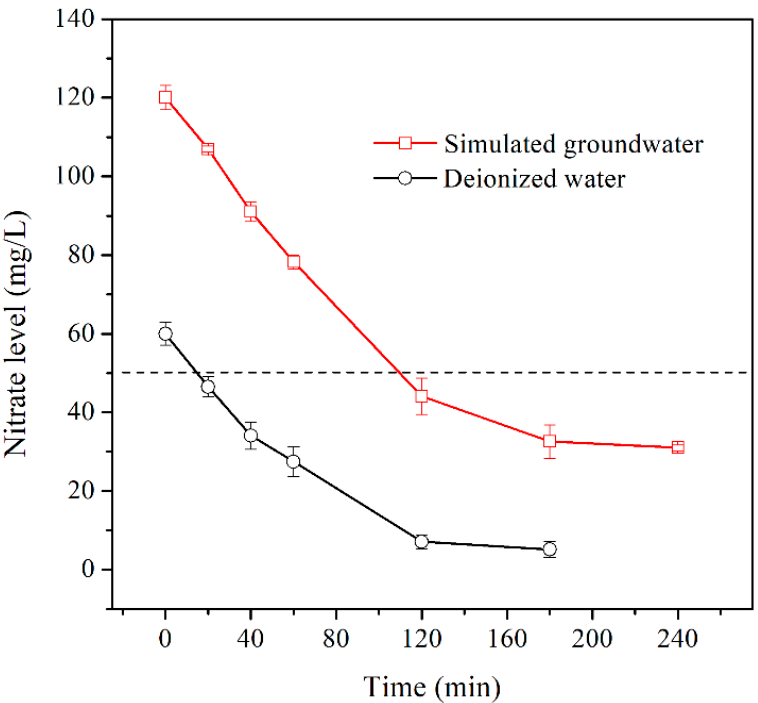
Figure 7. The reduction of NO 3 − from simulated groundwater and deionized water in the UV/C 2 O 42 − /Fe 3+ process. Experimental conditions: [NO 3 − ] 0 = 60 or 120 mg/L, [C 2 O 42 − ] 0 = 3 mM, [Fe 3+ ] 0 = 0.05 mM, I 0 = 10.2 mW/cm 2 (wavelength = 365 nm), [DO] 0 = 0.5 ± 0.1 mg/L, pH ini. = 7.0 ± 0.2, and T = 25 ± 0.5 °C. Error bars represent the standard deviation from three experiments. Error bars smaller than symbols are not visible.